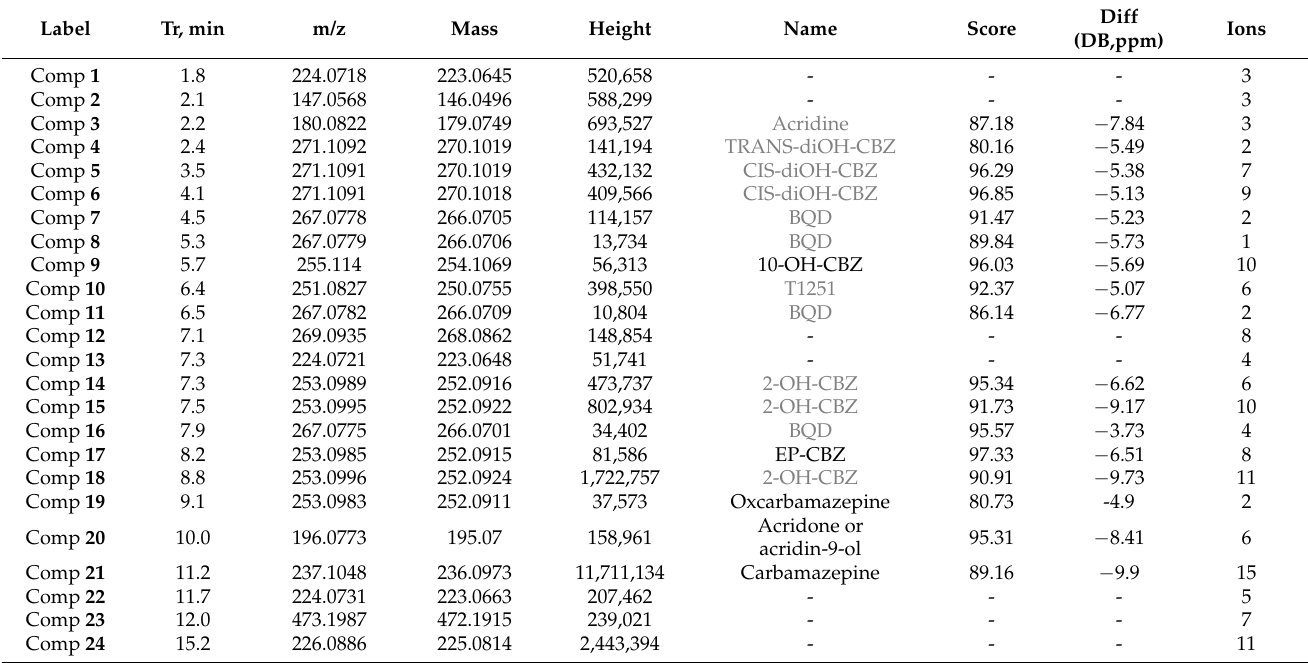
Table A4. Results of screening of major compounds. Sample pH = 5.0. Experimental conditions: [CBZ] = 50.0 mg/L; identified by the